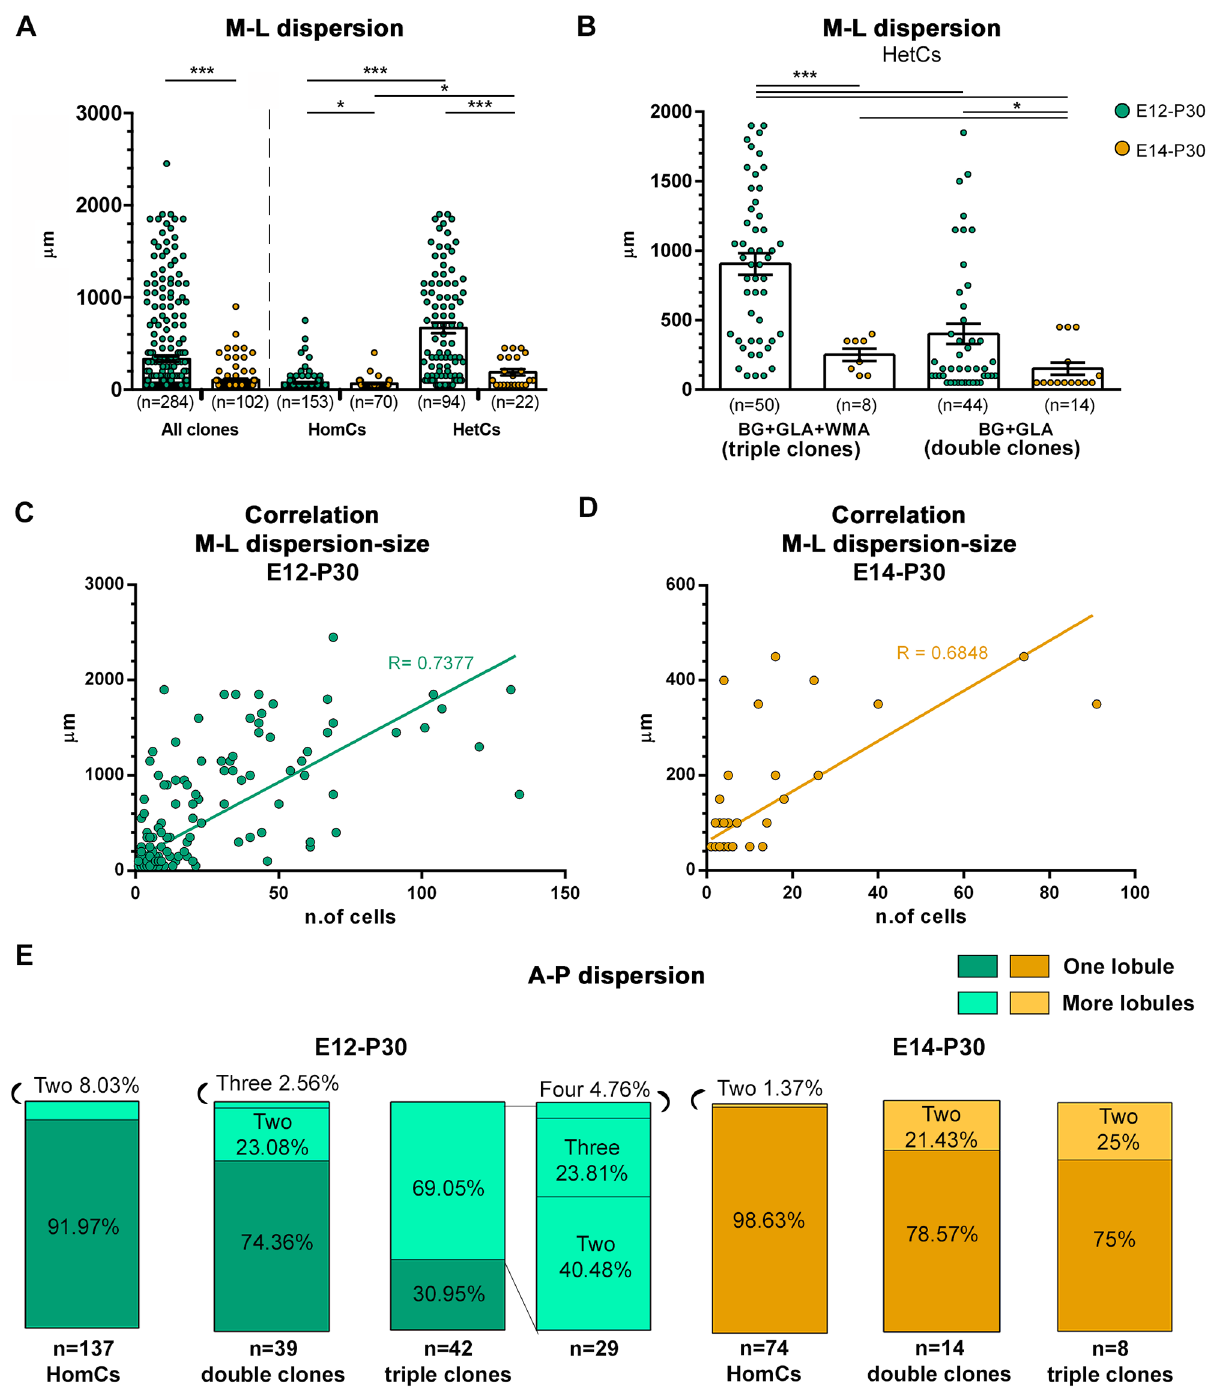
Fig 4. Quantitative analysis of clone dispersion along the M-L and A-P axes. (A,B) The M-L dispersion of clones tagged at E12 (green) or E14 (orange) is estimated as the longest intraclone cell distance along the M-L axis. (A) Scatterplots show that dispersion greatly decreases in E14-P30 clones compared to E12-P30 clones. HomCs are mostly found in a single cerebellar section, whereas HetCs are much more dispersed. (B) Among HetCs, triple clones are more expanded than double clones in both populations. Namely, E12-P30 triple clones are the most dispersed. (C,D) Correlation analysis shows a positive correlation between clonal size and M-L dispersion in both E12-P30 (C, n = 254 clones) and E14-P30 (D, n = 92 clones) populations ( P < 0.001). (E) Distribution along the A-P axis of E12-P30 (green) and E14-P30 (orange) clones found in lobules. HomCs and double clones tagged at E12 mostly settle in a single lobule, whereas triple clones are often found in more than one lobule. E14-P30 clones are overall found in one lobule. Within lobules, cortical cells of HetCs were mostly found on the same side (i.e., lobular wall) divided by the WM (67% and 86% of E12-P30 and